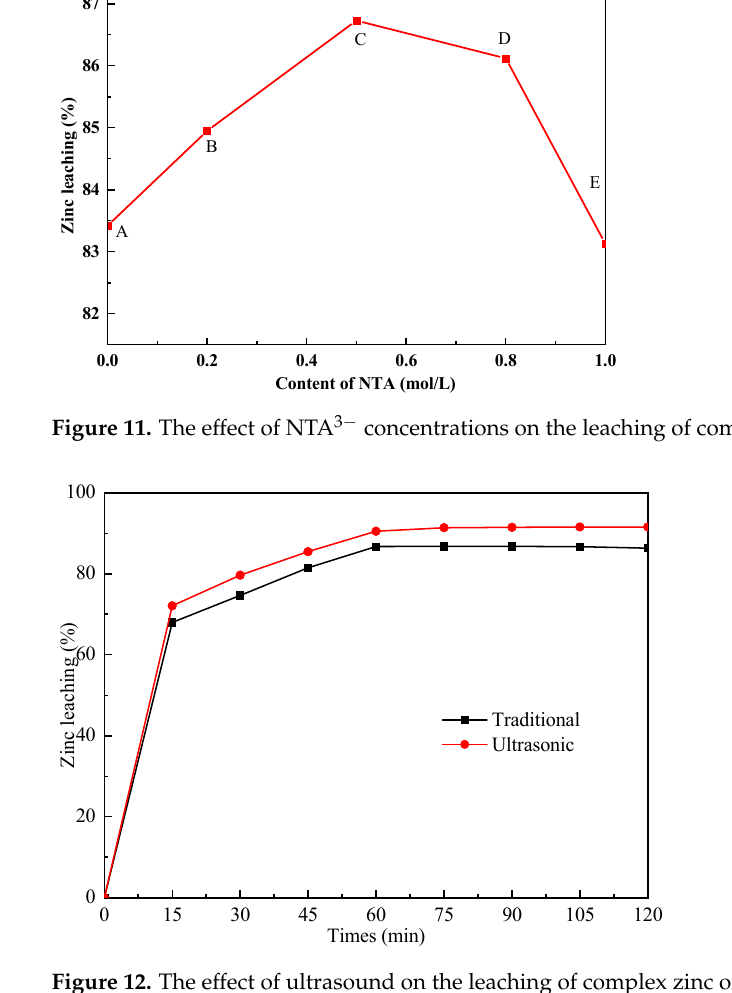
Figure 12. The effect of ultrasound on the leaching of complex zinc ore .